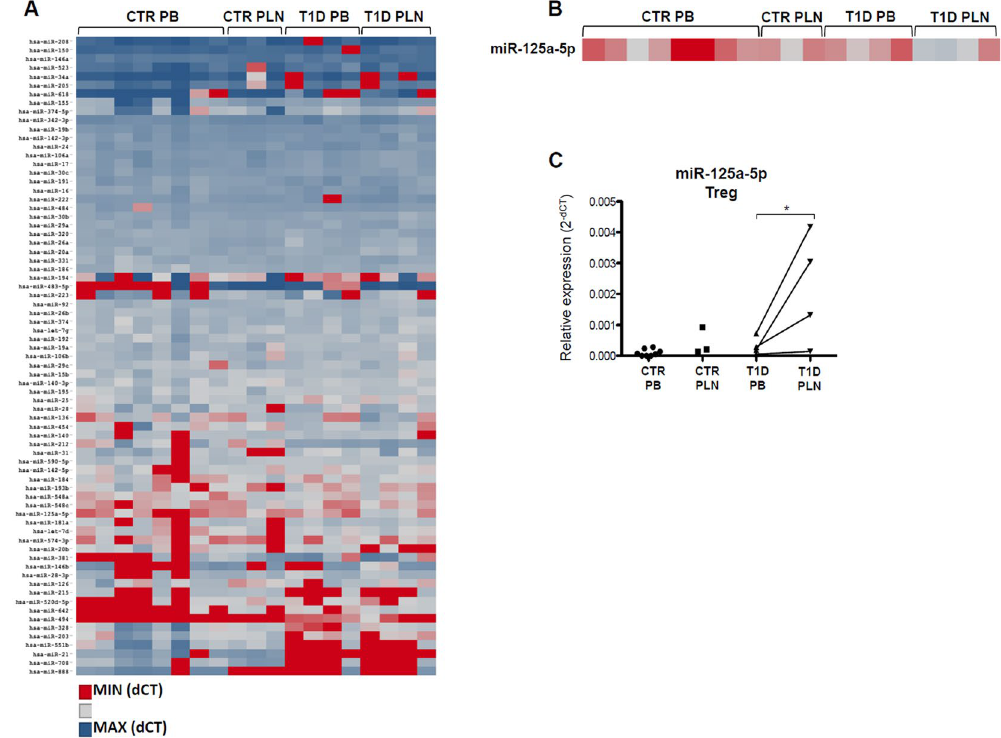
Figure 1. MicroRNA expression profiles reveal that miR-125a-5p is over-expressed in Treg cells isolated from PLN of patients with T1D. ( A ) microRNA expressions in Treg cells isolated from peripheral blood (PB) of non-diabetic control (CTR) donors (n = 8), pancreatic lymph nodes (PLN) of controls (n = 3) and from PB and PLN of patients with T1D (n = 4) is reported in the hierarchical heatmap. Expression values are reported as delta cycle threshold (dCT) values normalized using three different small RNAs (RNU6, RNU44, RNU48) and represented by scale colour of normalized dCT values [Red- low expressed microRNAs; blue- highly expressed microRNA]. Euclidean complete linkage clustering method was used to infer the data in the heatmap clustering graph. ( B ) Zoom-in of heatmap graph reporting miR-125a-5p expression values [Red- low expressed microRNAs; blue- highly expressed microRNA]. ( C ) The expression levels of miR-125a-5p were extrapolated from the heat map shown in panel B. Dots connected by a line represent paired samples. * p < 0.05 paired 2-tailed “Student t-test” on dCt.